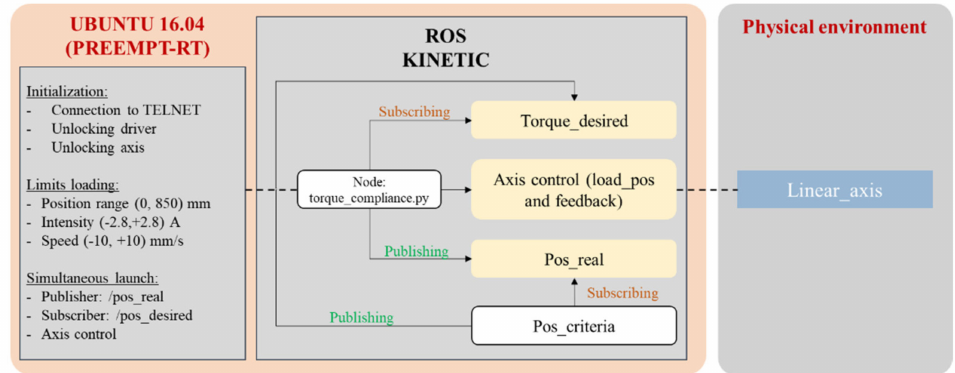
Figure 6. Block diagram of the Axis torque